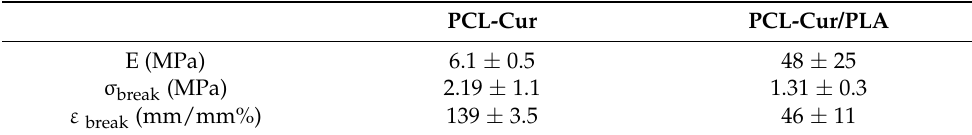
Table 2. Mechanical properties of electrospun